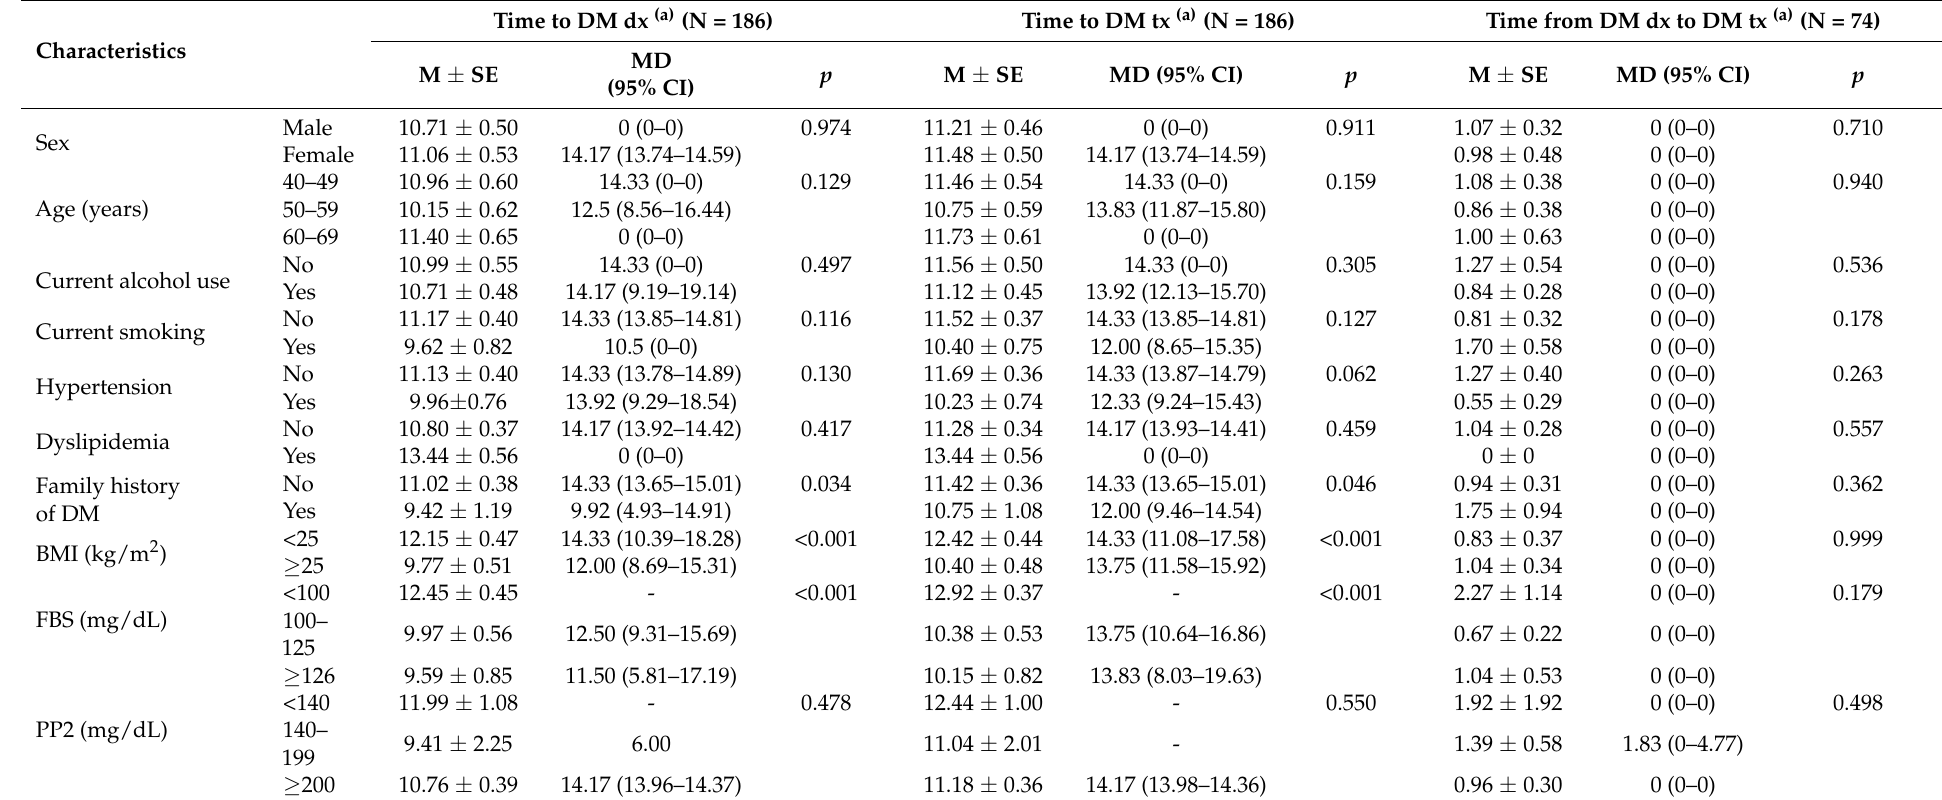
Table 3. Time to DM diagnosis and DM treatment according to participants’ characteristics at the 1st